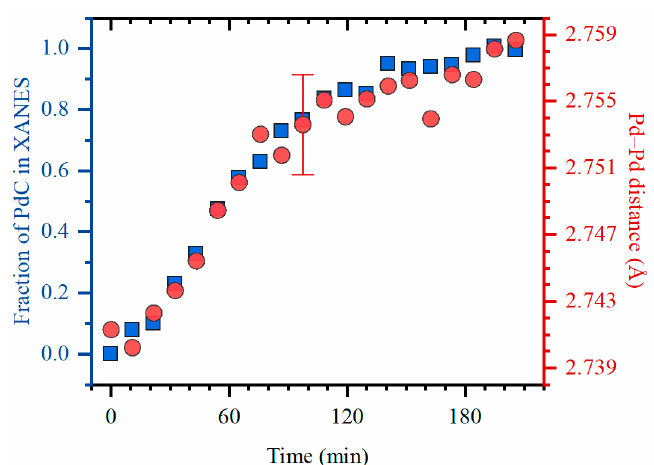
Figure 2. The results of LCF of XANES (blue squares, left ordinate axis) and first shell Pd–Pd interatomic distance obtained from EXAFS (red circles, right ordinate axis) for the experimental XAFS data collected during exposure to ethylene at 50 °C. The error bar corresponds to the maximal uncertainty in the fitted values of R Pd-Pd .